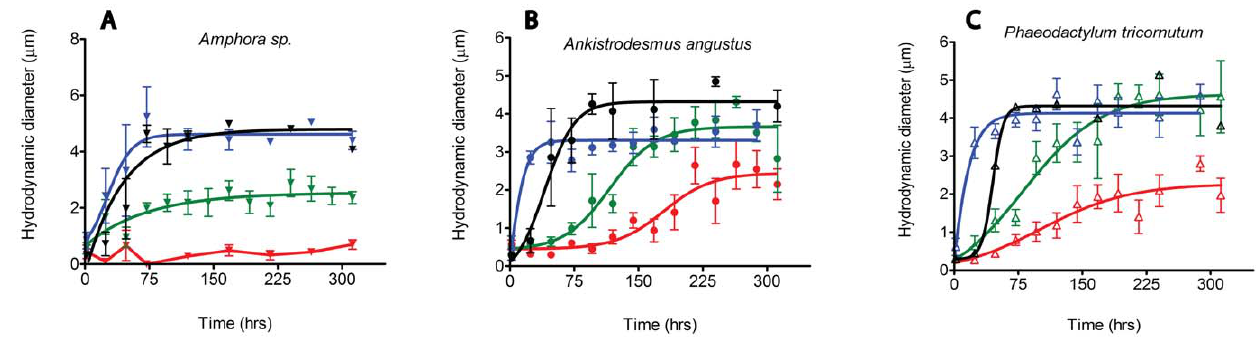
Figure 1. Assembly kinetics of EPS monitored with DLS. (A) Assembly kinetics of EPS of Amphora sp. (B) Assembly kinetics of EPS of Ankistrodesmus angustus (C) Assembly kinetics of EPS of Phaeodactylum tricornutum EPS assembly in Ca 2 + -free ASW (black) was monitored to investigate assembly kinetics with decreased divalent ion availability. Different concentrations of ENs (polystyrene nanoparticles): 0 (red), 10 (green) and 100 ppb (blue), were added to investigate the effect of ENs on EPS microgel formation.